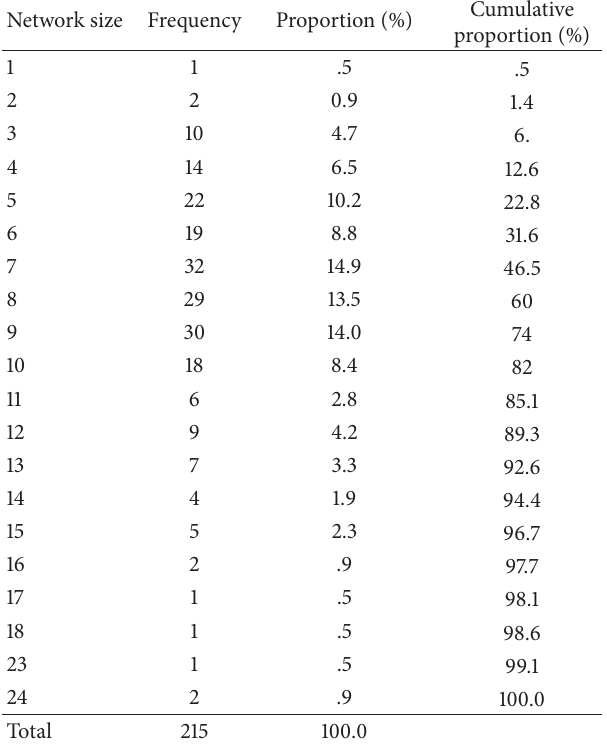
Table 1: Demographic characteristics of participants in study. Table 2: Network size of participants in study. Network size Frequency